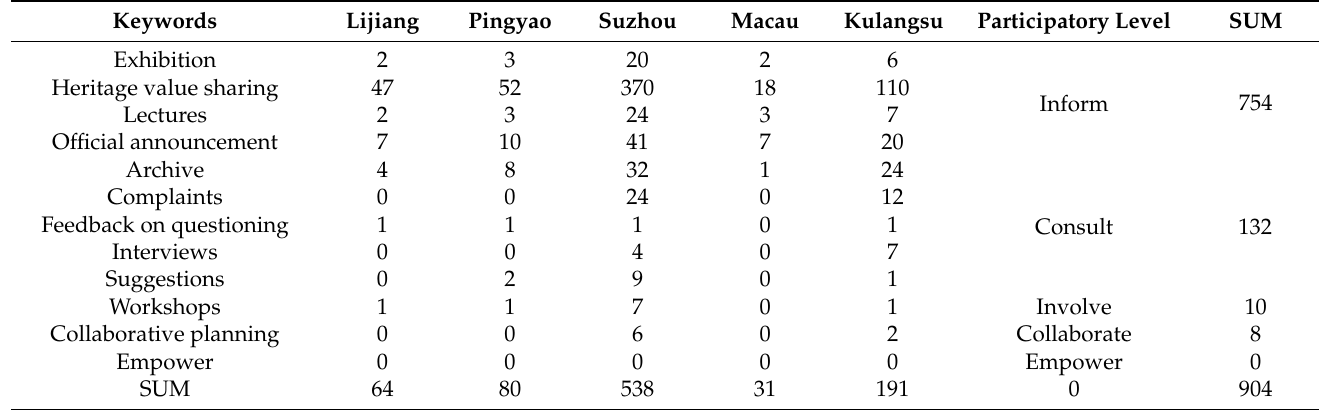
Table 4. Participatory Degrees Assessment on Weibo in the Cultural Heritage Management Process in China.